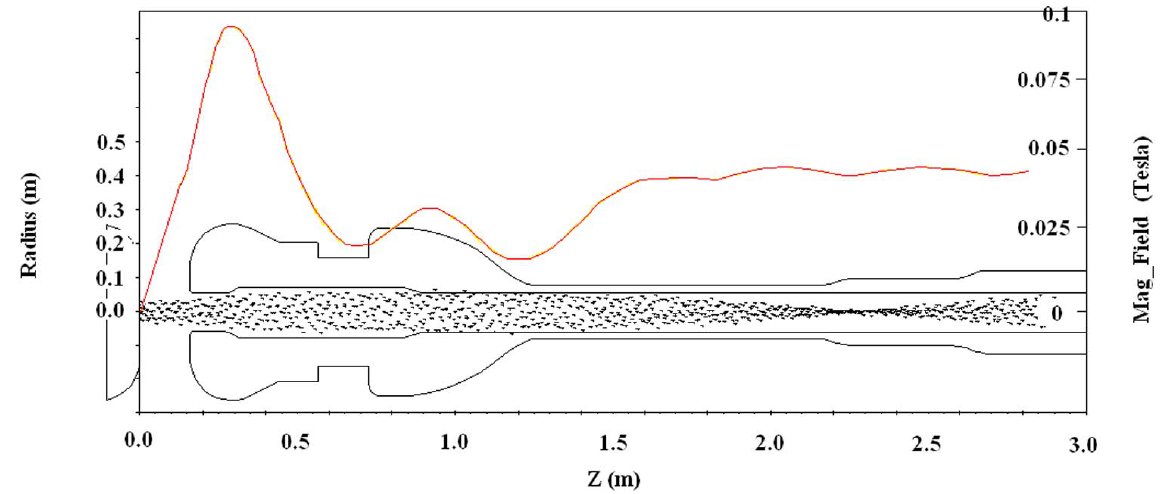
FIG. 12. (Color) Axial magnetic field distribution along the beam